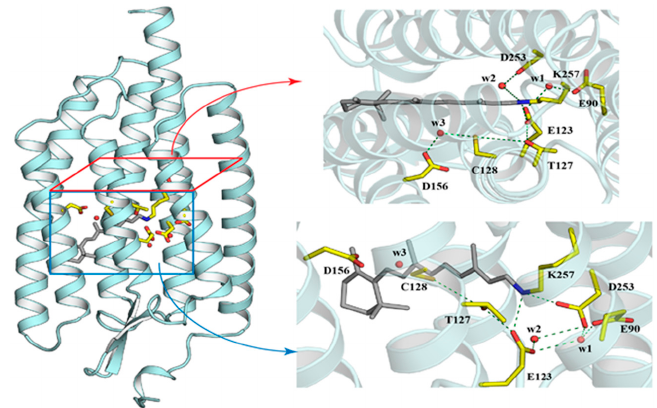
Figure 1. X-ray crystallographic structure of Chlamydomonas reinhardtii channelrhodopsin-2 ( Cr ChR2) (PDB: 6EID [10]). The protonated Schiff base of retinal and the side chains of key residues are shown as grey and yellow sticks, respectively. Water molecules are shown as red spheres. Dashed lines indicate hydrogen-bonding interaction.